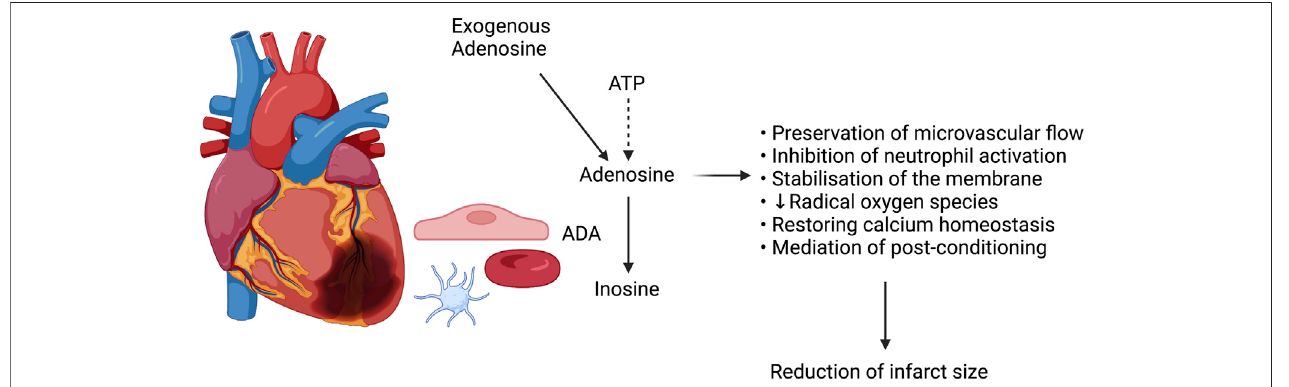
FIGURE 1 | A schematic representation of adenosine ’ s protective role in myocardial